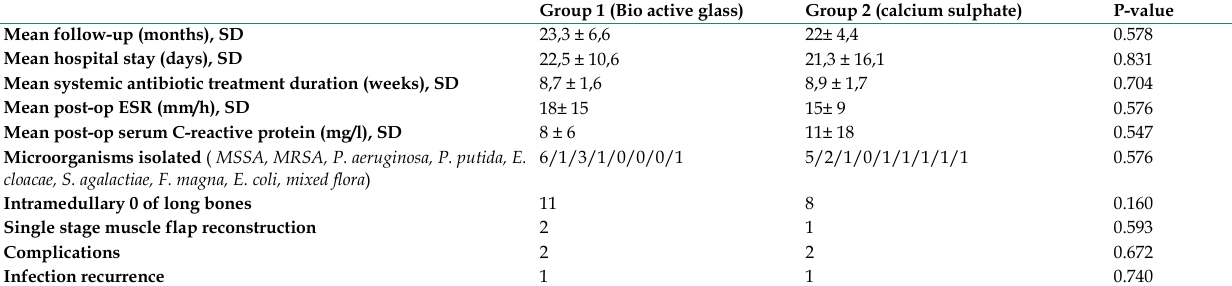
Group 1 (Bio active glass) Group 2 (calcium sulphate) P-value